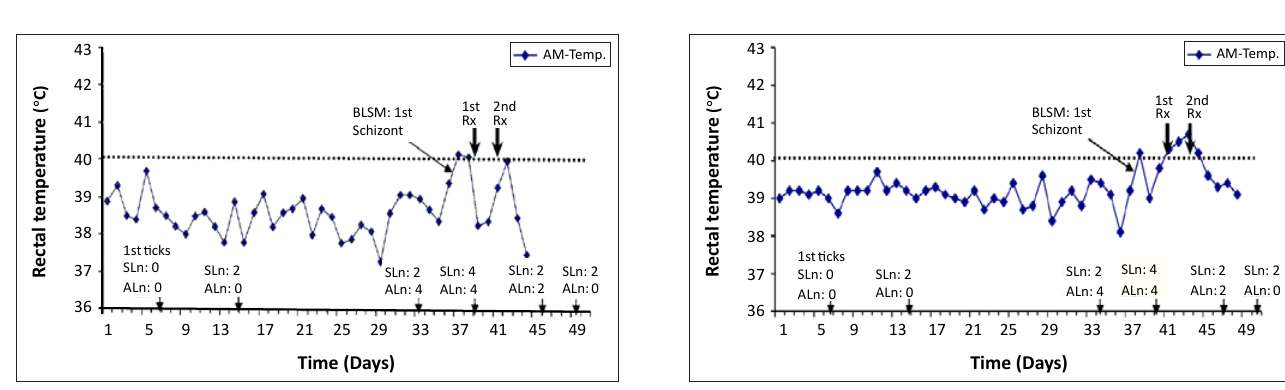
FIGURE 3: Animal 210: Blood smear findings, lymph node findings and day of treatment in relation to rectal temperature over time.